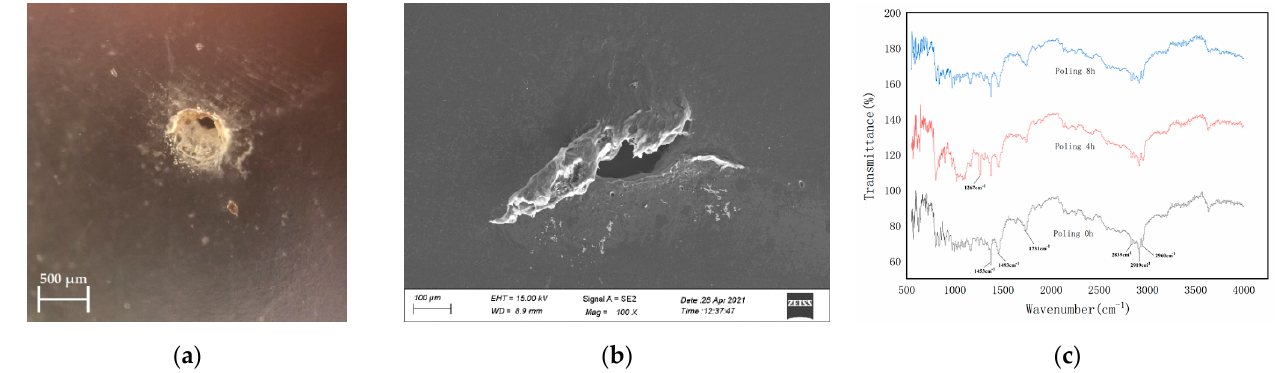
Figure 8. The surface morphology of the breakdown-point for sample after being tested under non-uniform DC electric field and the assessed results of the FTIR. ( a ) The optical microscope photo; ( b ) the SEM image; ( c ) results of the FTIR.